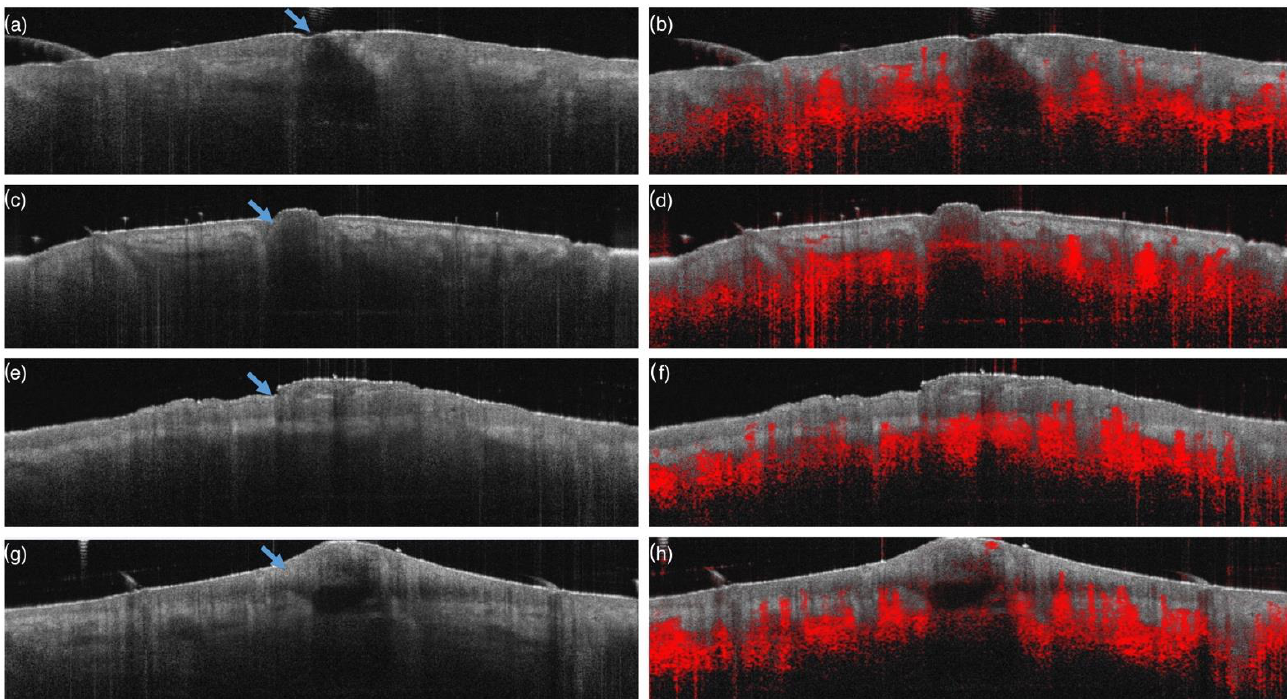
Figure 4. D-OCT images of a closed comedo (arrow) with the typical reverse-v-shaped morphology ( a ) showing the presence of significant vascular signal (red color) in dermis mainly at the border but not at the core of the lesion ( b ); open comedo (arrow), which is characterized by a rectangular hypoechogenic structure, with a large and thick hyper-intense plug at the top ( c ) showing the presence of significant vascular signal (red color) in dermis mainly at the border but not at the core of the lesion ( d ); papule (arrow), which is a dome-shaped lesion characterized by a diffuse inflammatory infiltrate at the epidermis and dermis ( e ) showing a prominent vascular signal (red color) in dermis both at the border and at the core of the lesion ( f ); pustule (arrow), which is a dome-shaped lesion with multiple central oval cavities containing hyper-intense inflammatory aggregates ( g ) showing enhanced vascular signal (red color) in dermis both at the border and at the core of the lesion ( h